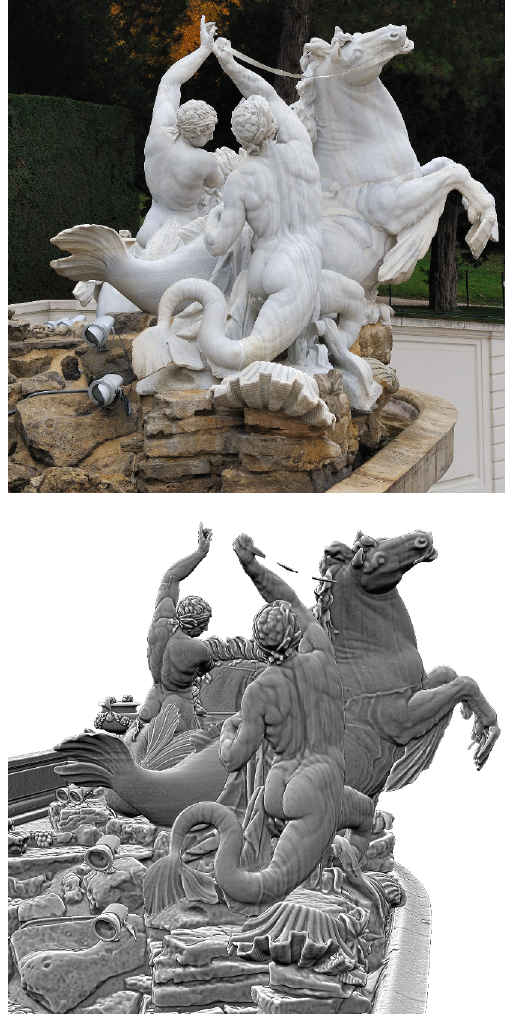
Figure 11. Influence of translucent material (i.e. marble) on the achievable accuracy of the TLS measurements. Upper: Marble sculpture with typical linear pattern. Lower: Triangulation model showing the same linear structures at the marble objects (i.e. Triton) while the sandstone is modelled